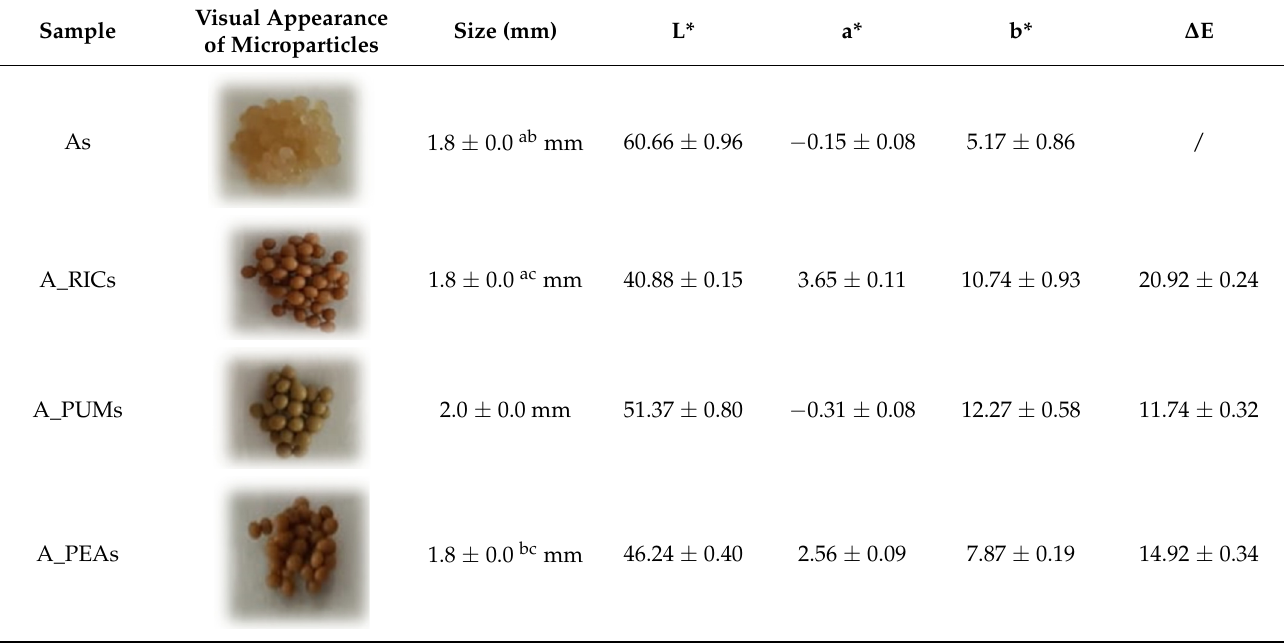
Table 3. Visual appearance, size and color parameters (L*, a* and b*) of microparticles.